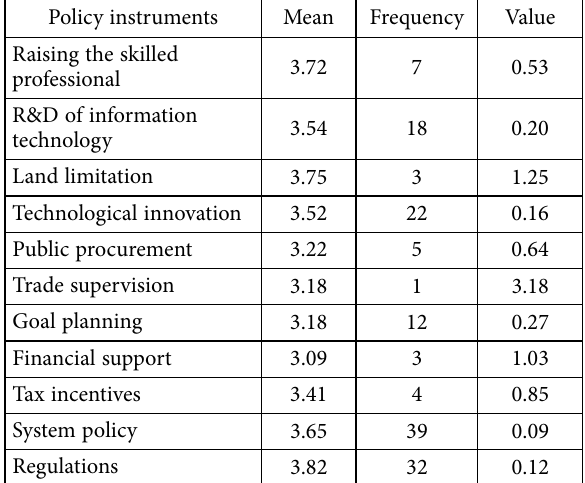
Table 9. Values of policies